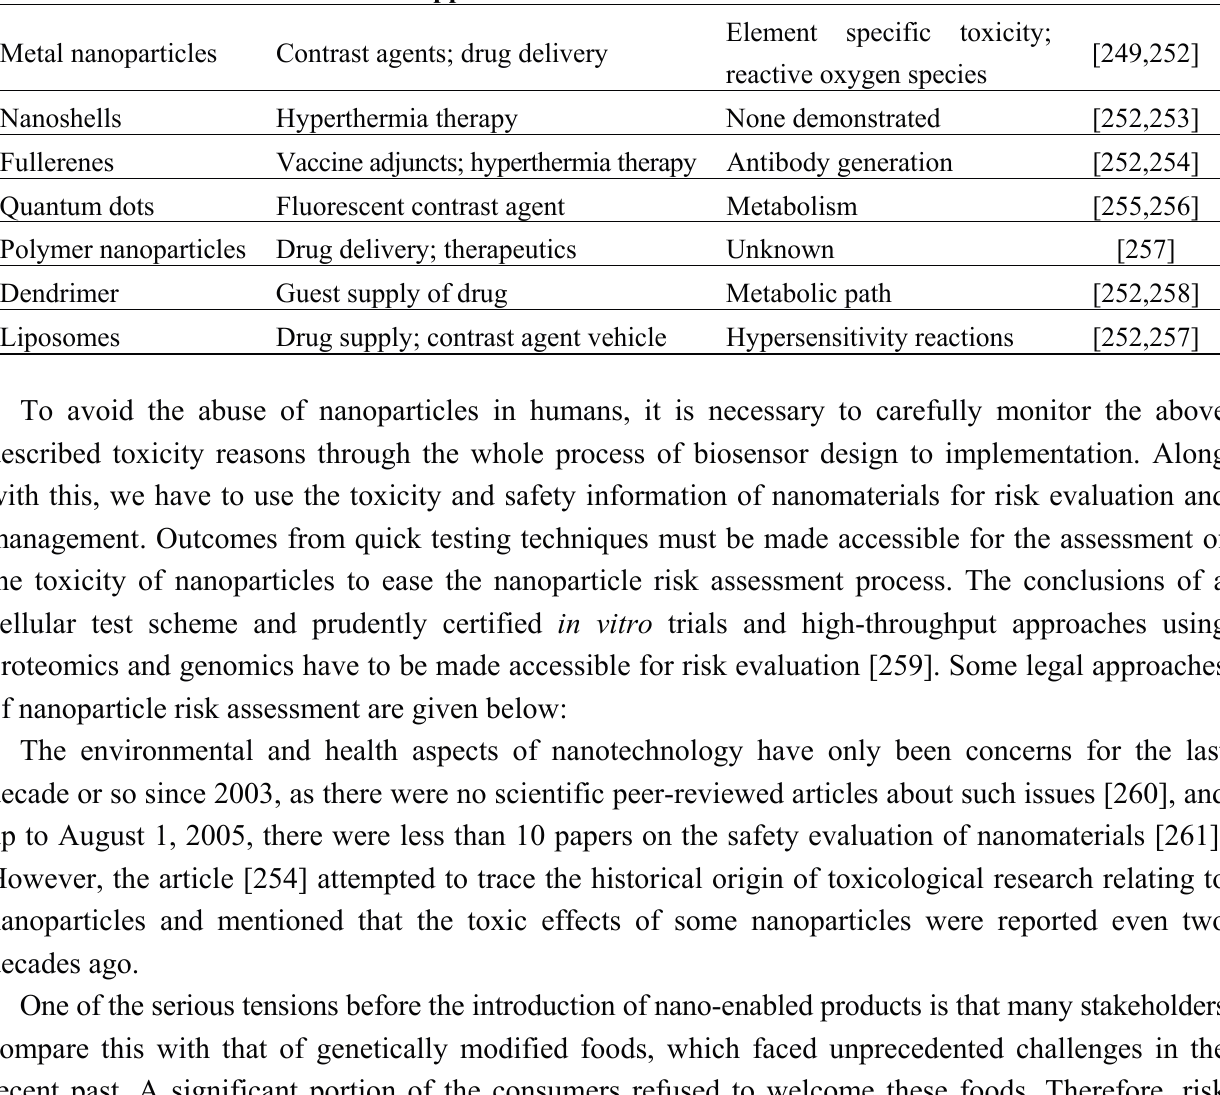
Table 13. Survey of dominant nanostructures, their applications and the biological areas of concern.